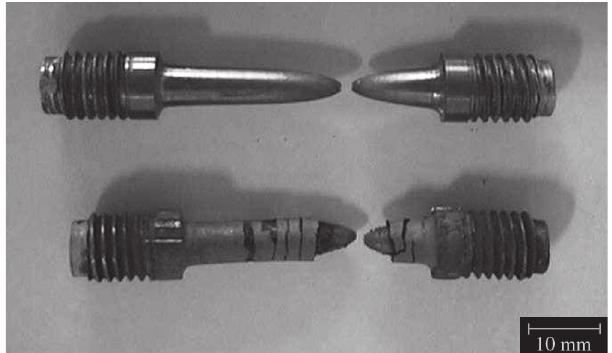
Figure 12. Typical aspect of the specimens after creep testing at 700 °C and 51.7 MPa. On top: in vacuum, rupture time = 162.7 hours; at the bottom: in air, rupture time = 51.1